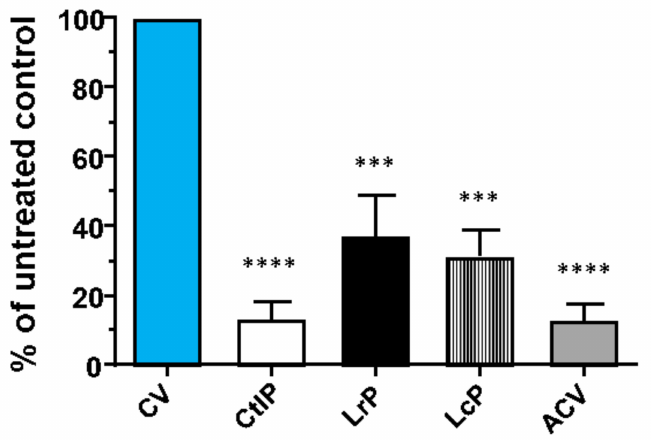
Figure 3. Antiviral activity of the peptides from donkey milk inoculated with L. rhamnosus 17D10 (LrP), L. lactis subsp. cremoris 40FEL3 (LcP), and not inoculated (CtlP). The antiviral activity was evaluated against an HSV-1 clinical isolate. As positive control, the infected cells were treated with acyclovir (ACV, 2 µ M) or treated with DMSO as negative control (CV). The results presented in all panels were analyzed with Bonferroni post-test correction for multiple comparisons. *** p < 0.001, and **** p < 0.0001 versus calibrator sample